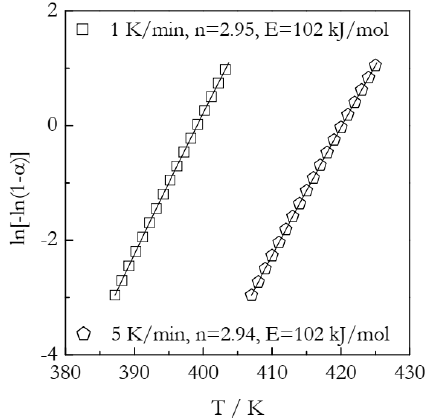
Figure 4. Simulated data fitted by Equation (16).